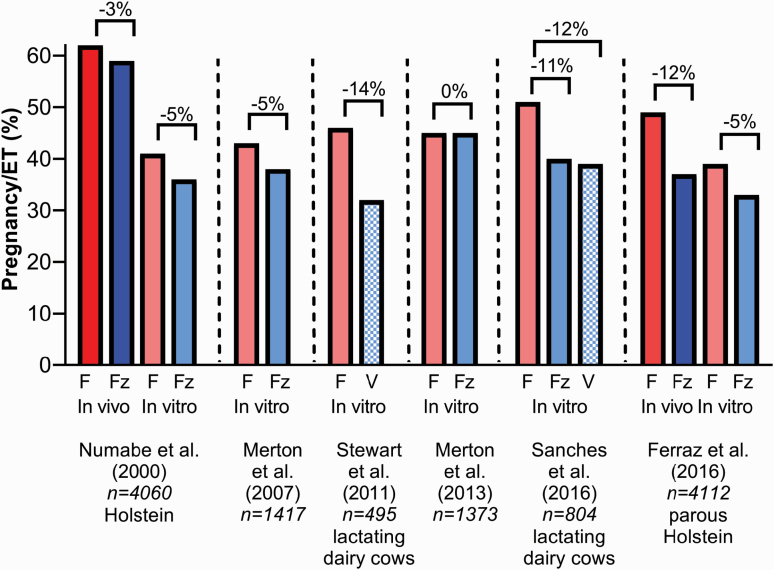
Comparison of pregnancy rates per ET for embryos produced in vivo (red and blue) and in vitro (light red and light blue) and that were transferred fresh (F; red or light red solid bars), frozen (Fz; blue or light blue solid bars), or vitrified (V; light blue hatched bars). The difference in pregnancy/ET between fresh and cryopreserved embryos is shown above each pair of bars. Data are from Numabe et al. (2000), Merton et al. (2007, 2013), Stewart et al. (2011), Sanches et al. (2016) and Ferraz et al. (2016).